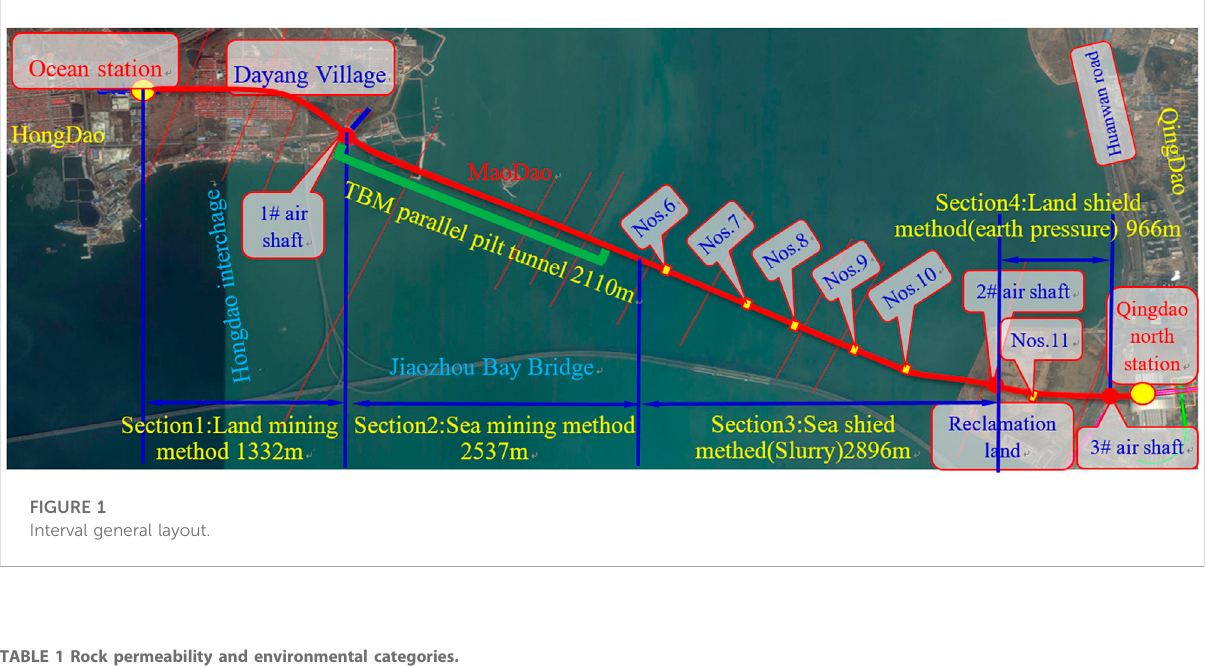
TABLE 1 Rock permeability and environmental categories.